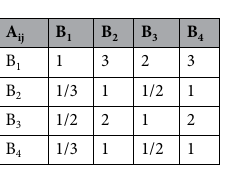
Table 3. Comparative criteria level matrix (Level 1 indicators).